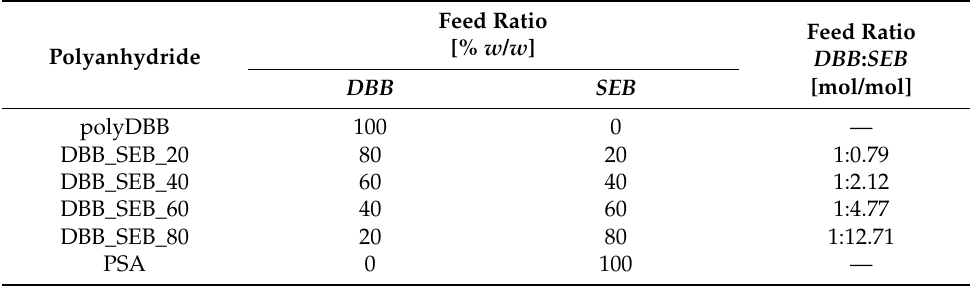
Table 1. Feed ratio of DBB and SEB